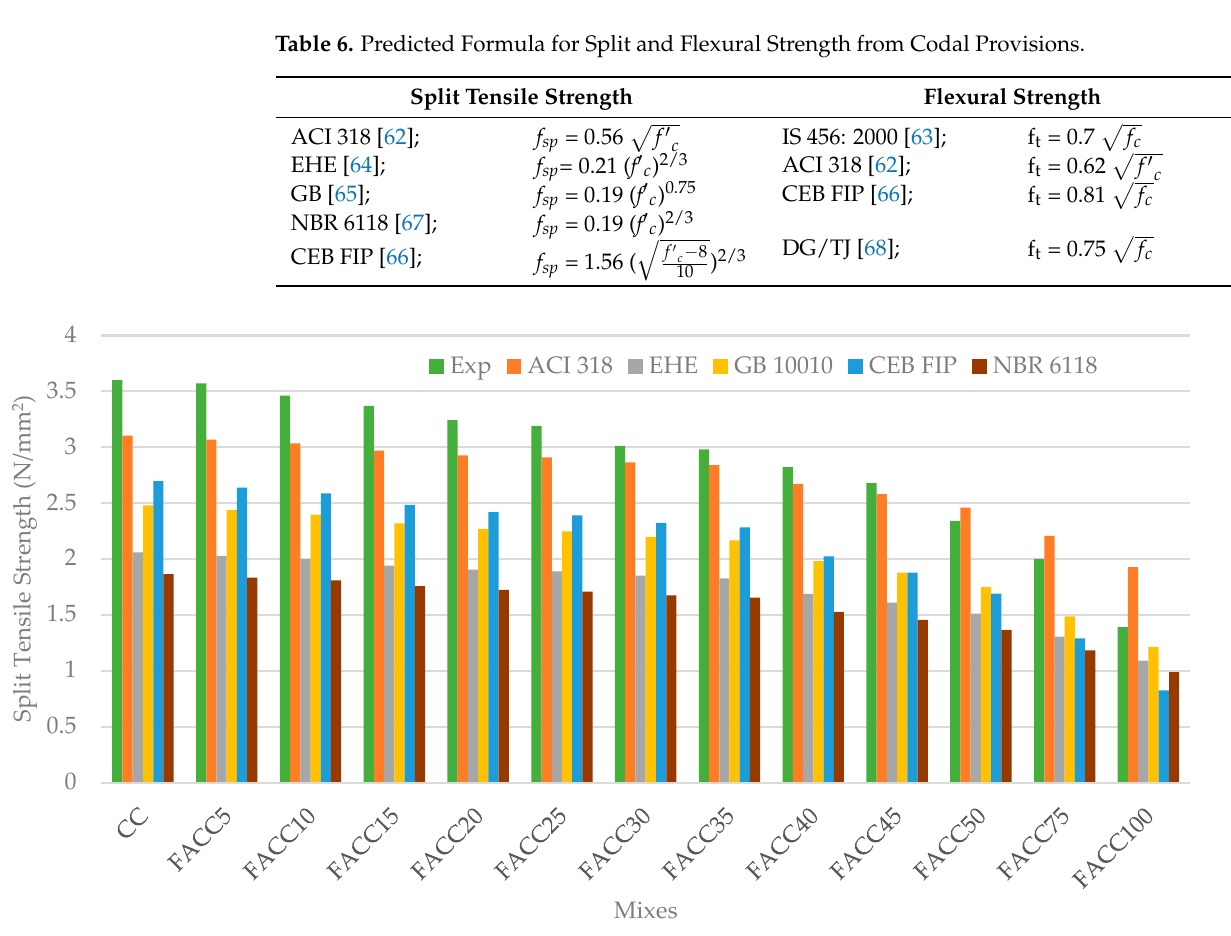
Figure 8. Comparison of Experimental Value to Predicted Split Tensile Values.